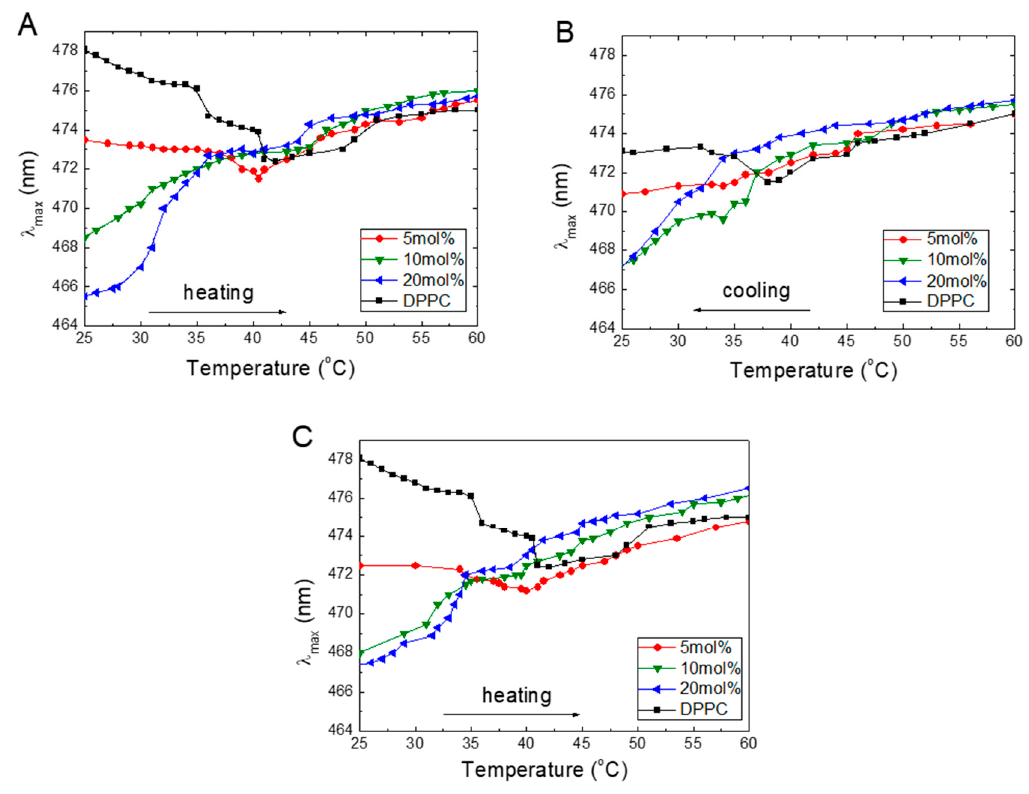
Figure 3. Temperature dependences of the positions of the ANS (16 µ M) fluorescence maxima ( λ max ) in DPPC (0.08 mg / mL) for TS during heating ( A ), cooling ( B ), and for Toc during heating ( C ).